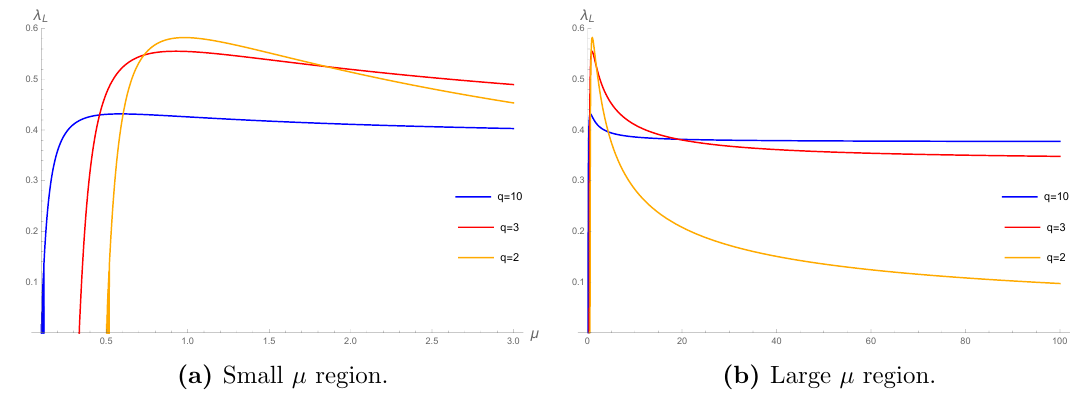
(a) Small (cid:22) region. (b) Large (cid:22) region. Figure 6. (cid:22) dependence of the Lyapunov exponent (cid:21) L . The yellow, red and blue curves are evaluated at p = 0 and q = 2, 3, 10